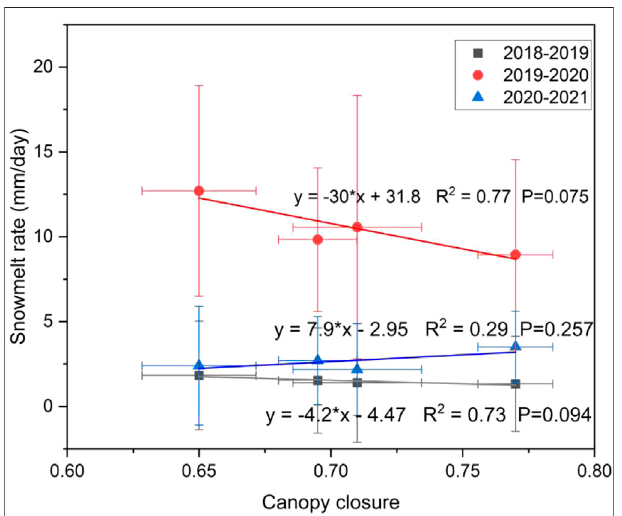
FIGURE 10 | Relationship between forest canopy closure ( θ ) and snowmelt rate ( S r ). Points of different colors and shapes represent different years. The gray square points represent 2018 – 2019, the red circle points represent 2019 – 2020, and the blue triangle points represent 2020 – 2021.